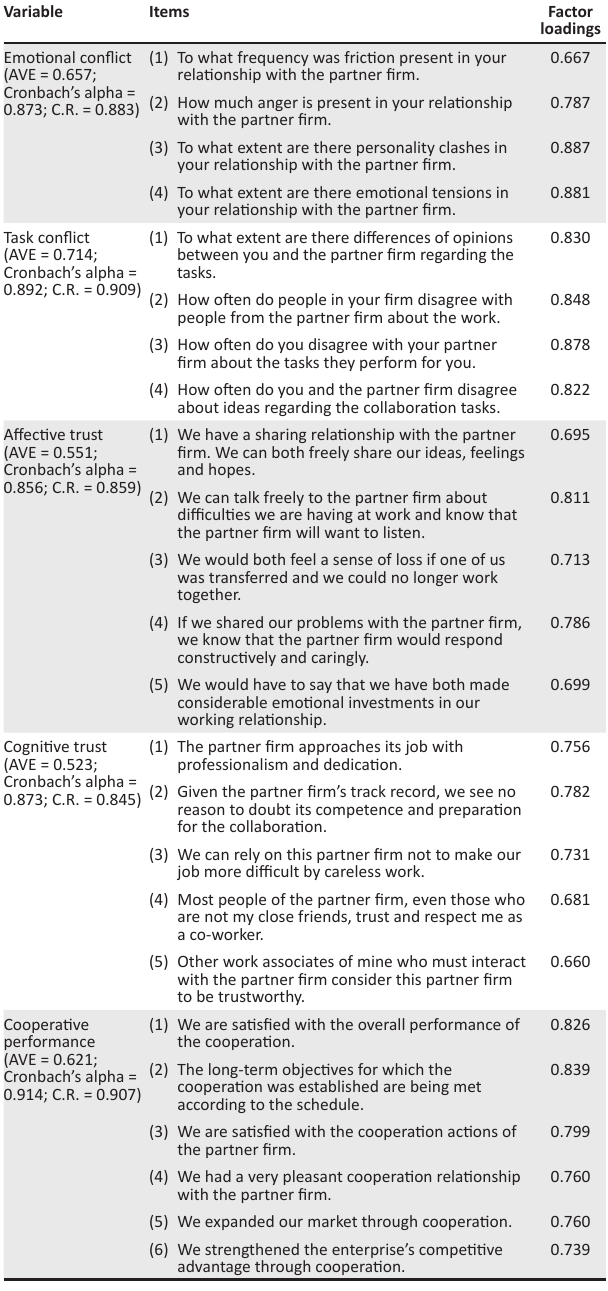
TABLE 1: Construct reliability and validity.